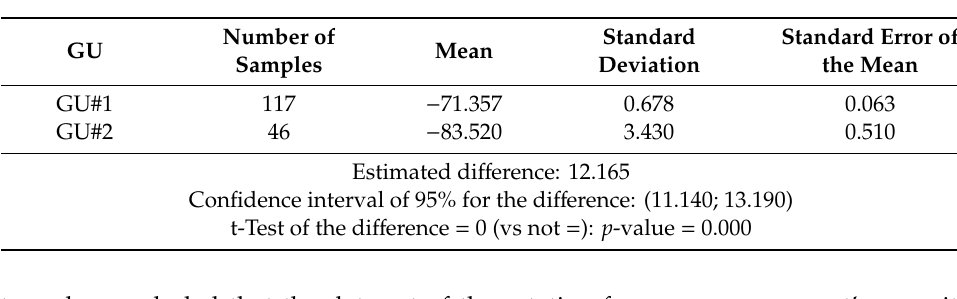
Figure 7. Trend of rotation frequency pattern of voltage (lower curve) and current (upper curve) signatures for GUs at Goiandira power plant: ( a ) GU#1; ( b ) GU#2.